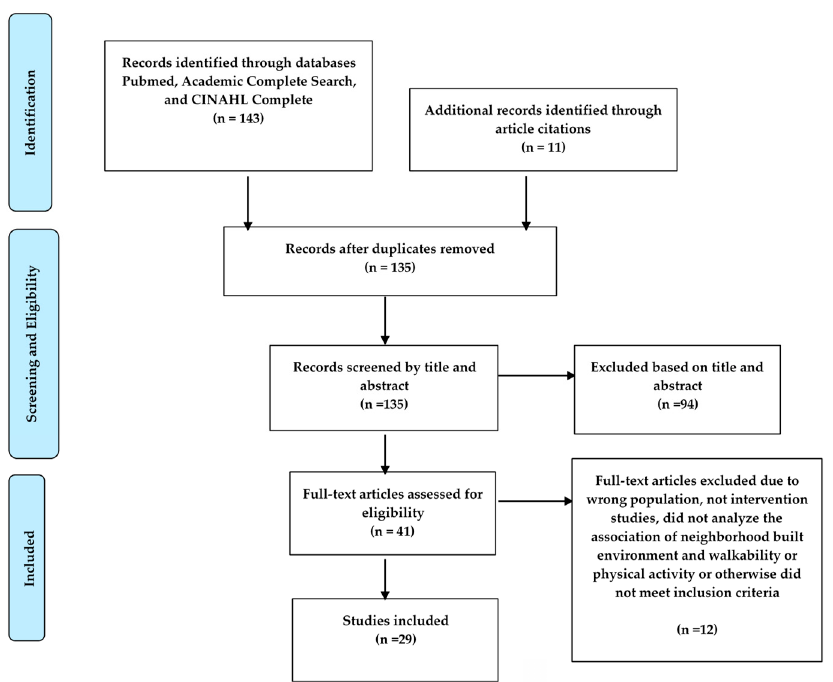
Figure 1. Article Selection Flow Chart.